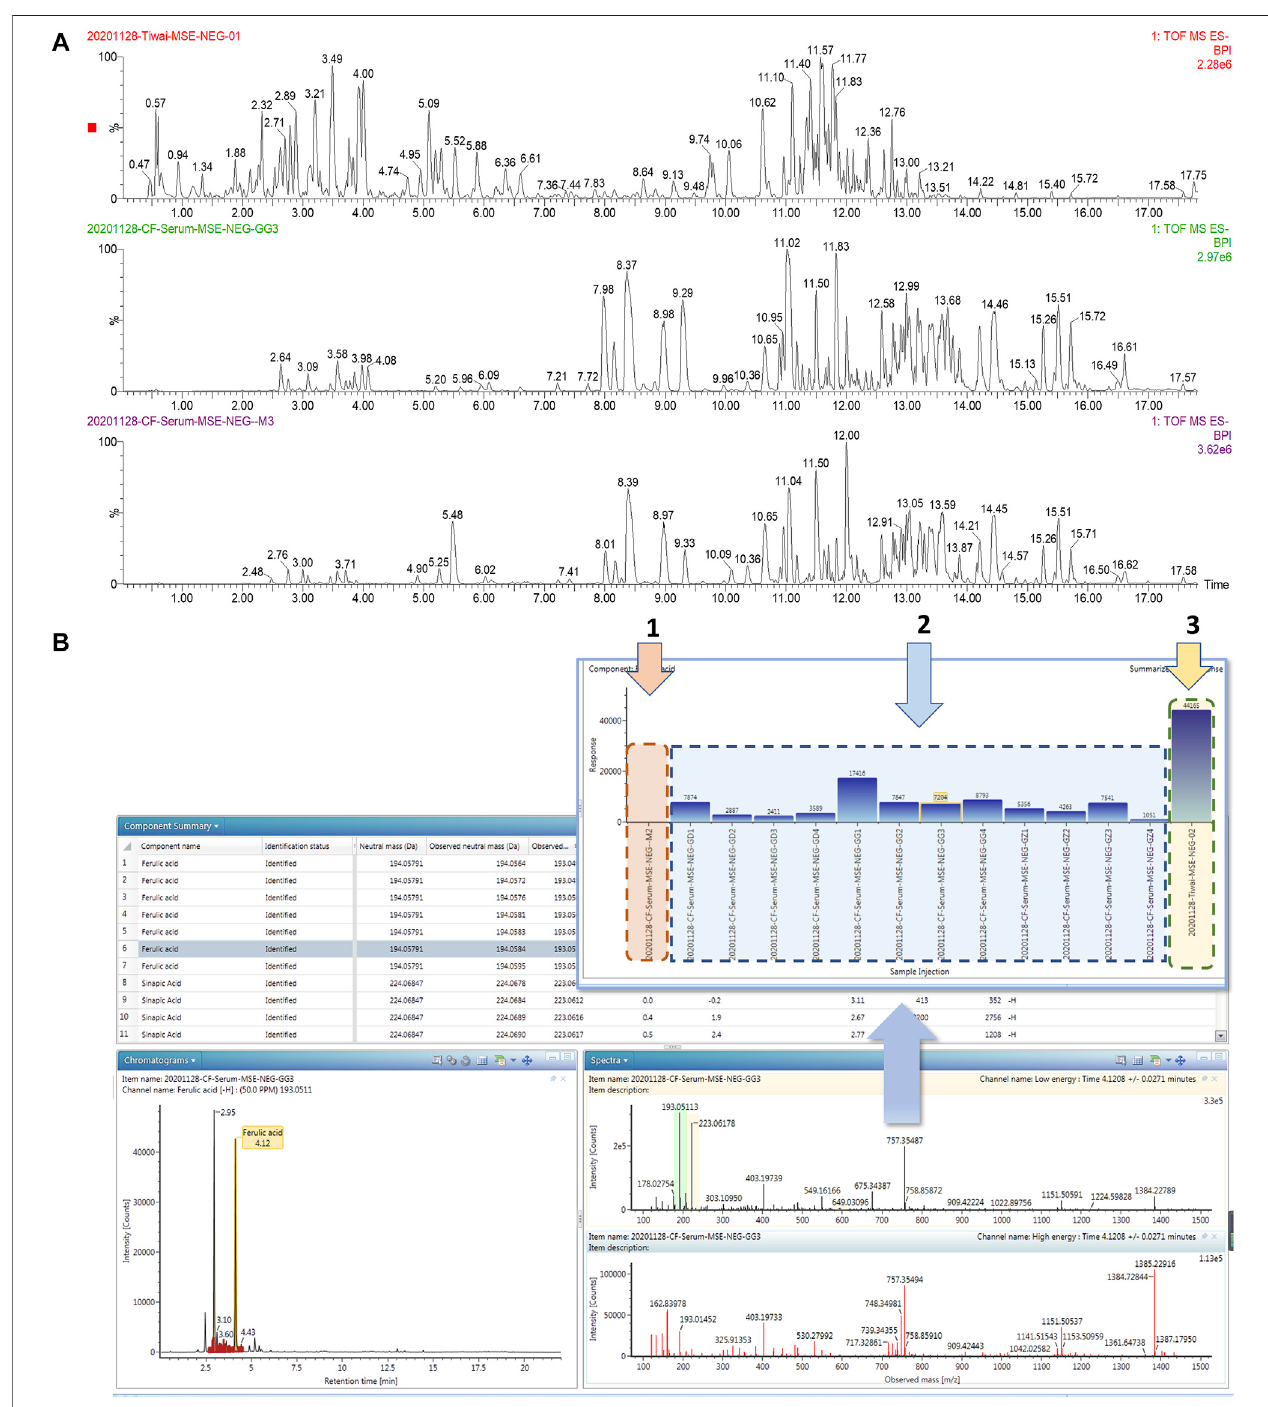
FIGURE 6 | Consultant analysis of ZBD in vivo based on UPLC-MS/MS combined with UNIFI ™ software. (A) Chromatograms of ZBD and serum from the model and ZBD-treated groups. (B) The results of matching MS/MS fragment ions and trend plot of the identi fi ed absorbed compounds based on the UNIFI database. 1: Relative content of ferulic acid in the (1) model group, (2) ZBD-treated group, and (3) ZBD group.